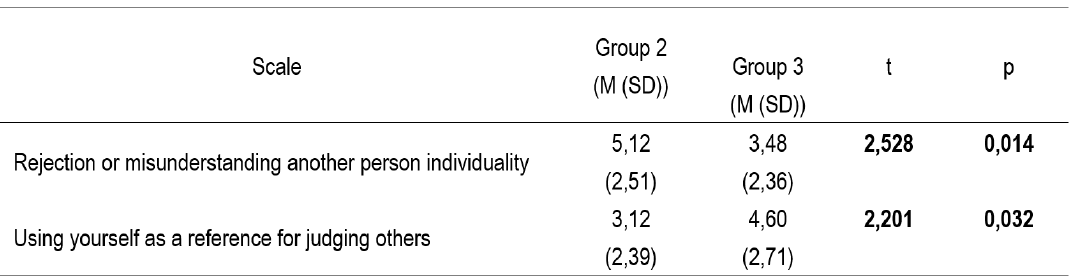
Indicators of communicative tolerance of mentors with medium and low levels of